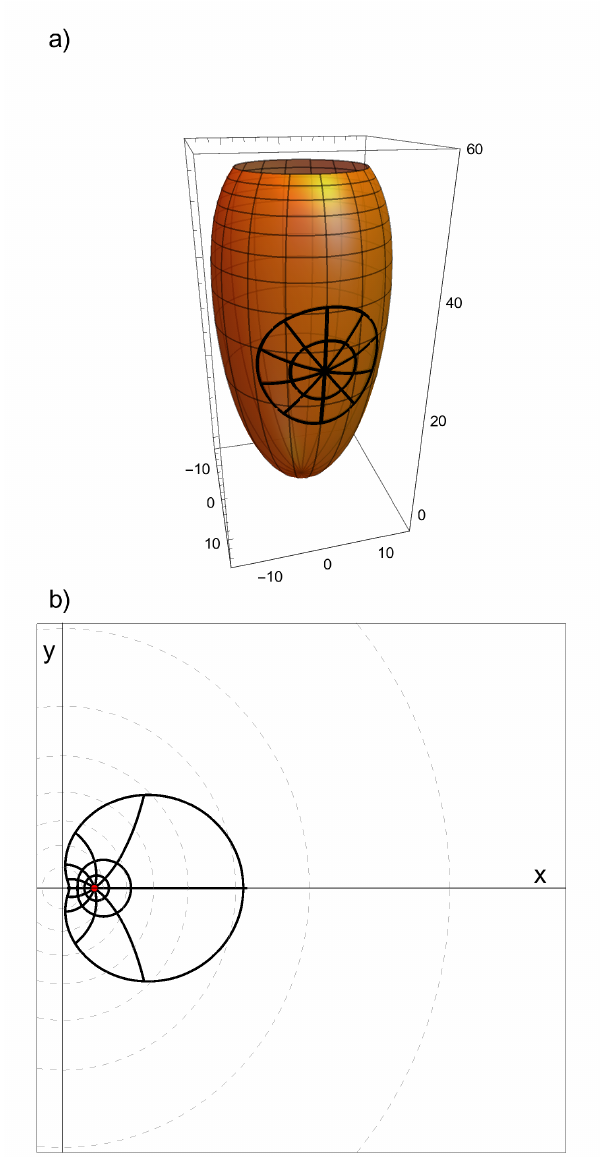
Figure 7. ( a ) two geodesic circles of radii 5 and 10 units (mm) centered at the point ( w = 0.25, φ = 0) on V 1. Radial geodesic ‘spokes’ of equal length are shown for each circle; ( b ) three geodesic circles of radii 5, 10, and 20 units on V 1 stereographically projected on E 2 . Their center point is shown in red. A = 525.6 and B =